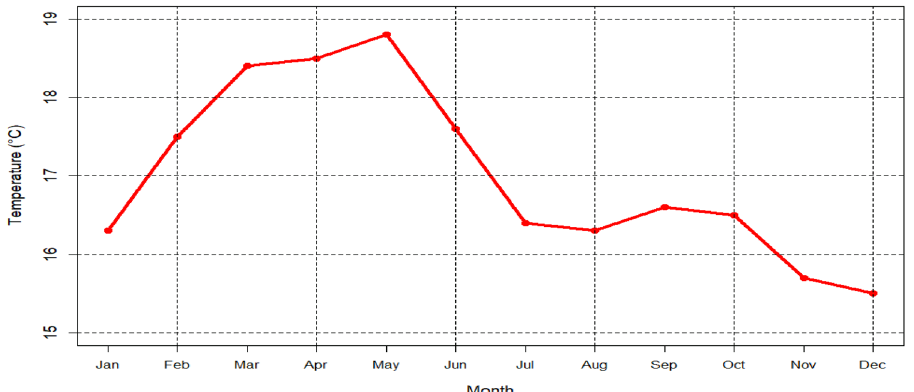
Figure 3. Mean temperature climatology (1981–2010) of Addis Ababa.